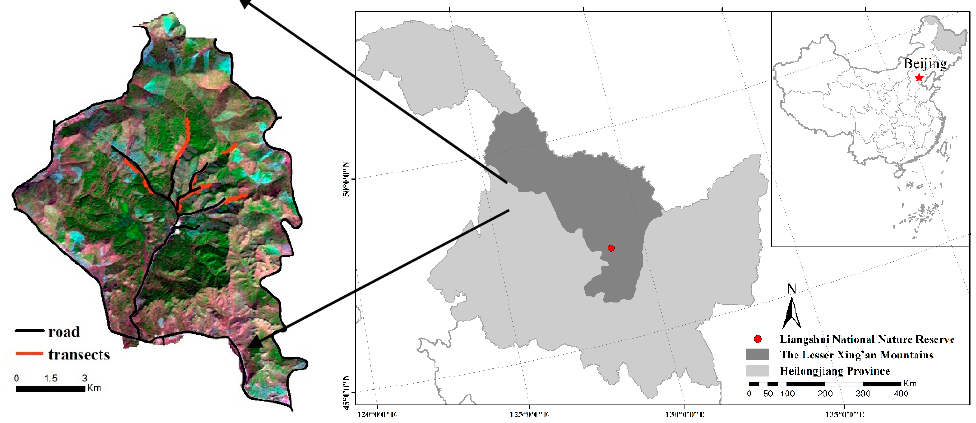
Figure 1. The study area located in the Lesser Xing’an Mountains, northeast China and transect